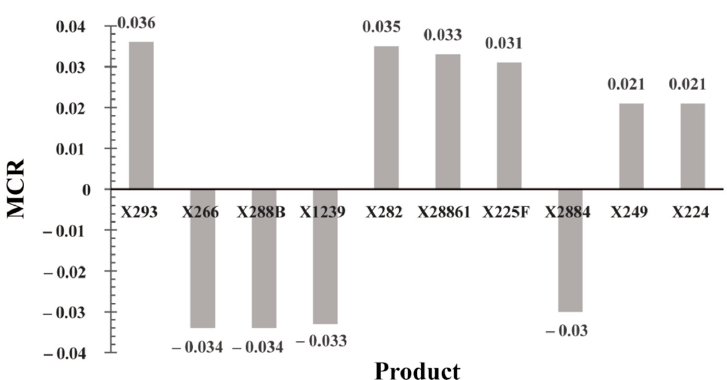
Figure 4. The value of 𝑀𝐶𝑅 s for different products.